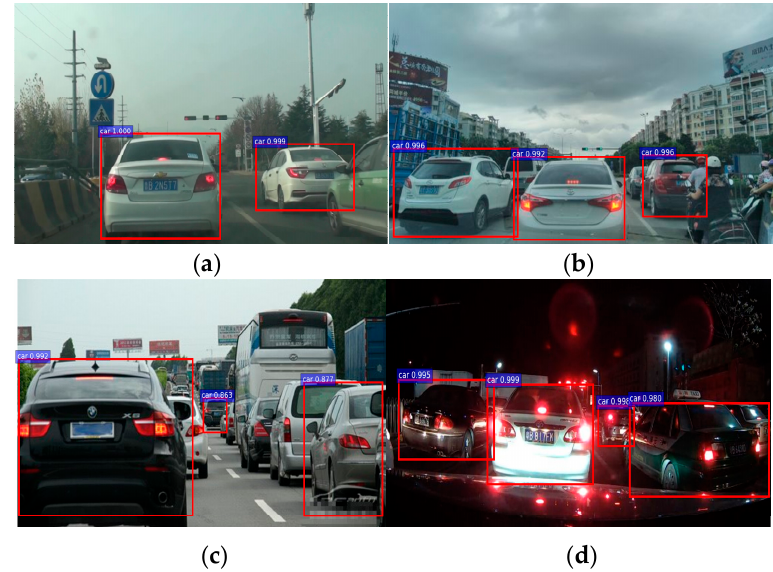
Figure 9. Some situations of occluded vehicle detection. ( a ) When vehicle occlusion is slight, the occluded vehicle is detected; ( b ) when vehicle occlusion is serious, some heavily occluded vehicles cannot be detected; ( c ) when vehicle occlusion is moderate, the detection result is uncertain in the daytime; ( d ) when vehicle occlusion is moderate, the detection result is uncertain at night.